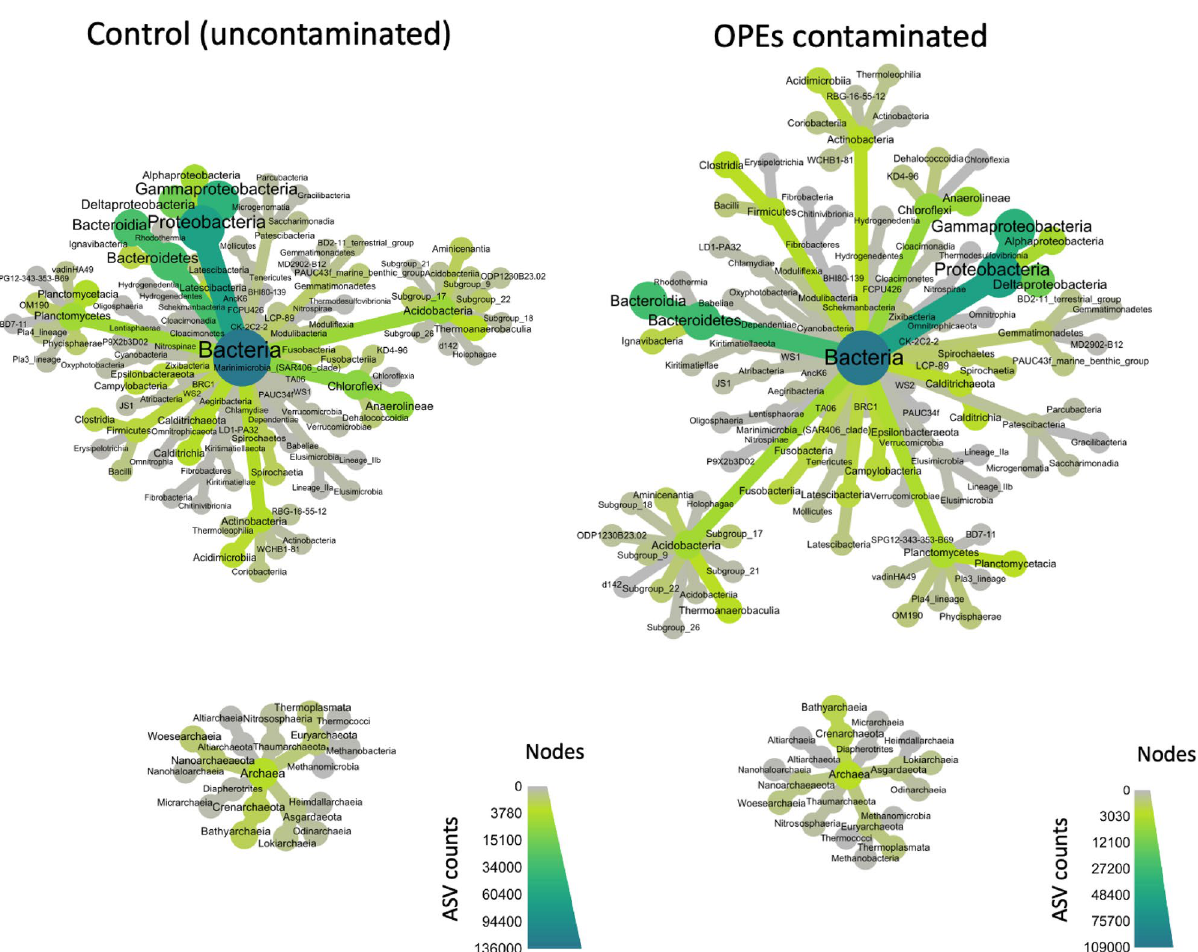
Figure 3. Heat tree of the taxonomical composition of the microbial community of the Marseilles’ WWTP outlet sediments at the Bacteria (up) and Archaea (down) phylum level: left, control (uncontaminated) and, right, OPE-contaminated. Even if the heat tree branches have a different spatial organization the main structure of the prokaryotic communities are similar (phyla composition). ASV, amplicon sequence